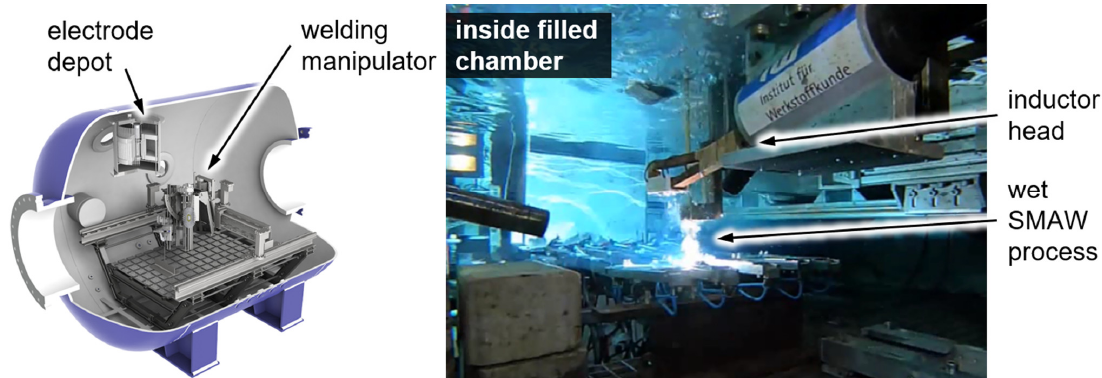
Figure 2. Pressure chamber for mechanized welding at simulated water depths and wet SMAW welding of hydrogen samples with currently uninvolved inductor in rest position. For microstructural analysis, samples were sectioned from weldments conducted at four different simulated water depths ( WD ) on different steel grades. Stick electrodes for wet welding of the type Aquaweld by Kjellberg Finsterwalde with a diameter of 3.25 mm complying with DIN 2302—E 38 0 Z RB 2 20 fr (PA, PB, PE, PG) were used as consumables. The welding parameters used at the different water depths are listed in Table 1. Table 1. Welding parameters (mean values of measured process parameters). Water Depth WD in m